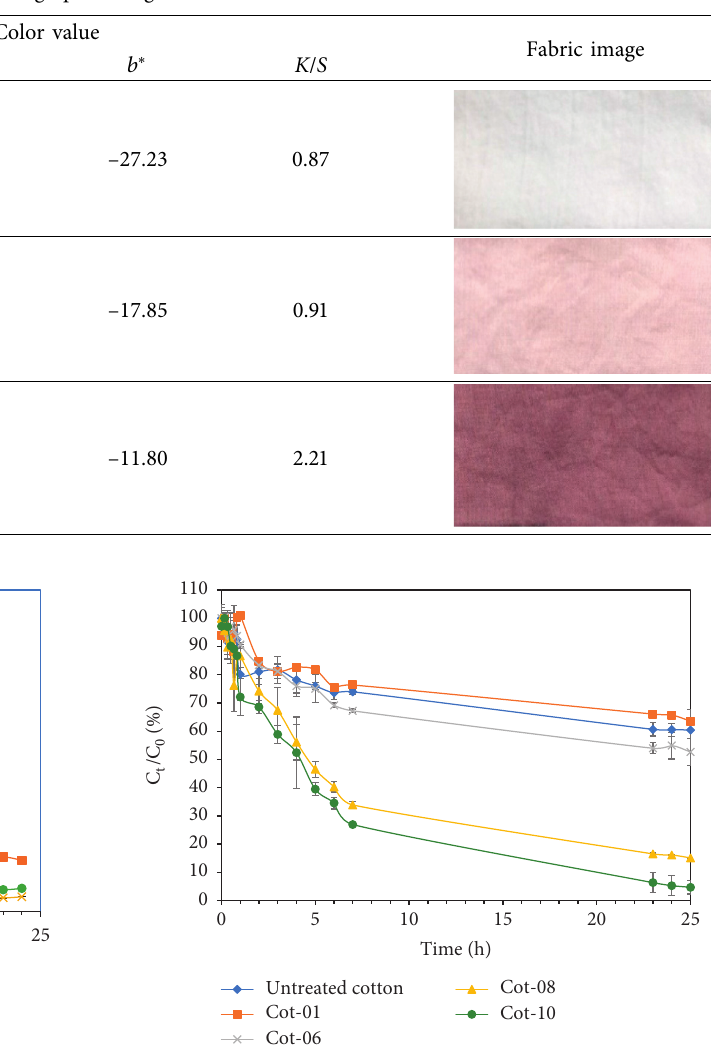
Figure 6: Catalytic reduction of CR using AuNPs-coated cotton 0 is the initial fabrics ( C 0 is the initial dye concentration, and C is the dye concentration at time t ). Table 2: Tearing strength values of fabric samples.